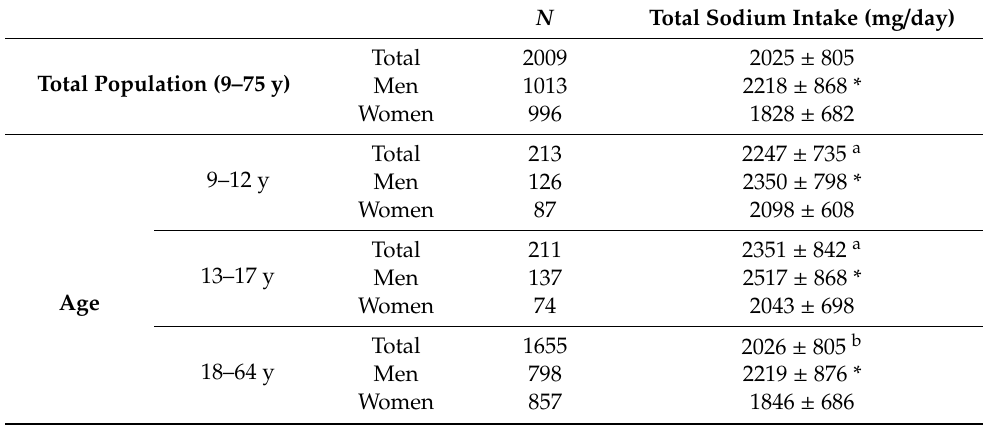
Table 1. Sodium intake from foods consumed by the ANIBES study population (excluding added table and cooking